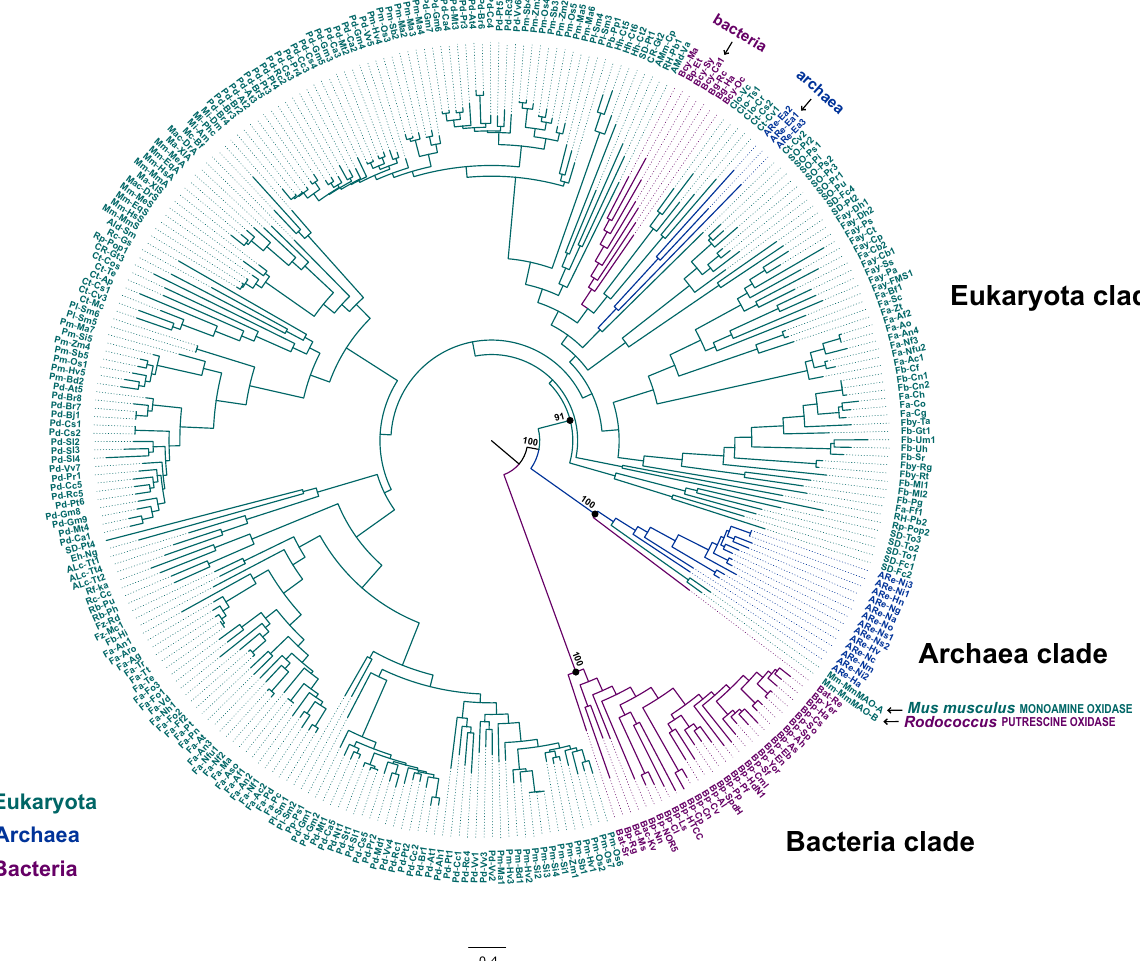
Figure 1. Maximum likelihood tree depicting the phylogenetic relationships between eukaryote PAOs and related PAO-like enzymes in bacteria and archaea; the tree is drawn to scale, with branch lengths measured in number of substitutions per site. Bootstrap support values (ultrafast bootstrap approximation) over 1000 replicates are reported in correspondence of the main nodes. The analysis involved 300 amino acidic sequences (see Supplementary Table S1). Sequences are coloured according to the three main domains of life: eukaryote = green, archaea = blue, and bacteria = red. The three main clades are named as follow: Eukaryota clade, Archaea clade, Bacteria clade; prokaryotic sequences clustering within the Eukaryota clade and non- archaean sequences clustering within the Archaea clade are indicated by black